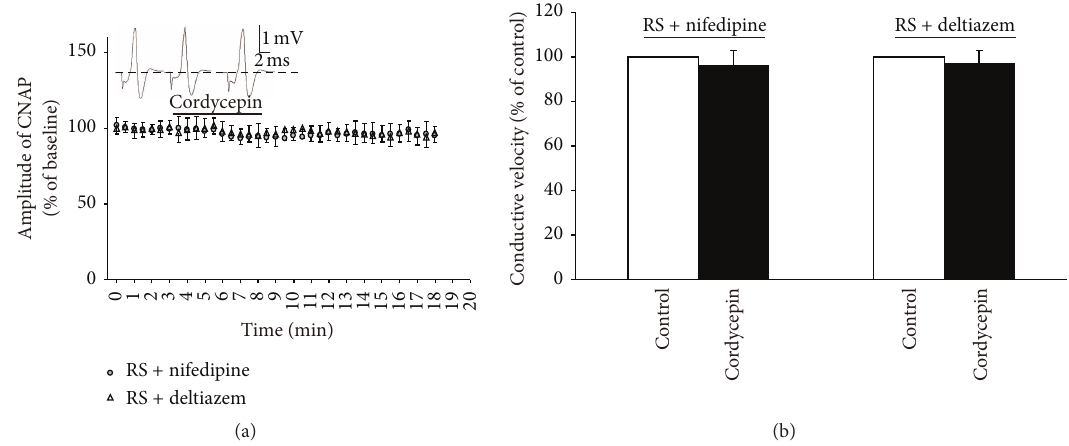
Figure 5: Effects of 50mg/L cordycepin on amplitude and conductive velocity of compound nerve action potential (CNAP) in RS supplementedwith10 𝜇 Mnifedipineor10 𝜇 Mdeltiazem.(a)Sampletraces(top)showtheCNAPrecordedbefore,during,andaftercordycepin was applied in RS + nifedipine medium. Below are the time courses of the effects of cordycepin on the amplitude of CNAP conduction. Horizontal bar indicates the bath application of cordycepin. (b) Summary of changes in conductive velocity of CNAP induced by cordycepin. The velocity of the stable state before the nerve was exposed to cordycepin is defined as the control value and scaled to